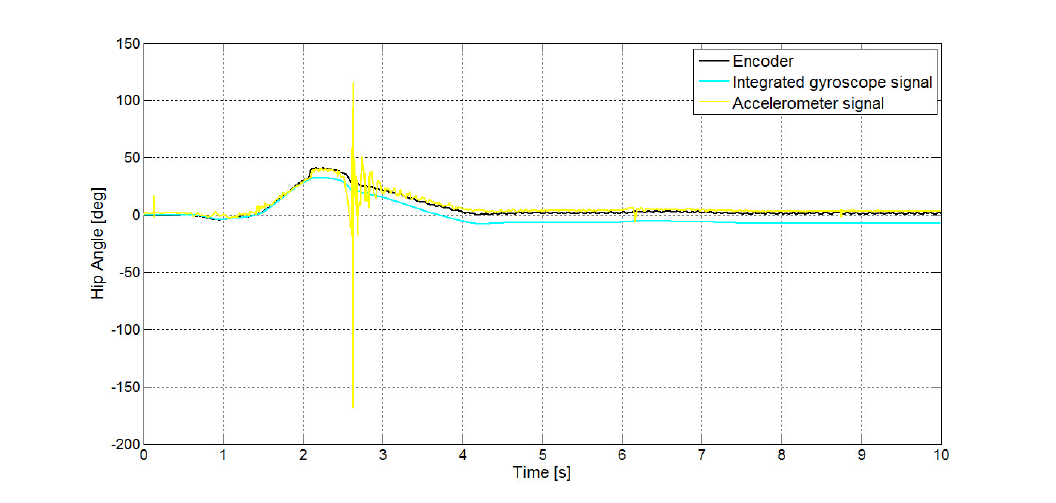
Figure 6. The integrated gyroscope signal and the accelerometer-based position estimation: ( a ) hip angle; ( b ) knee